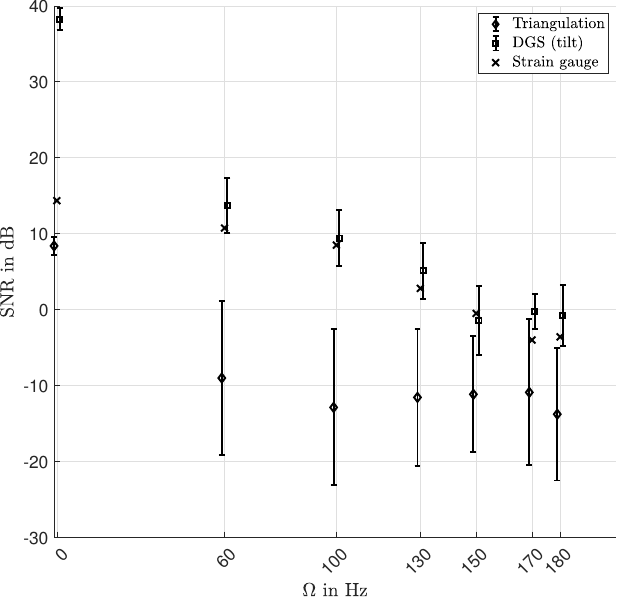
Figure 9. Median SNR and standard deviations (errorbars) over all measured angular locations at R = 170